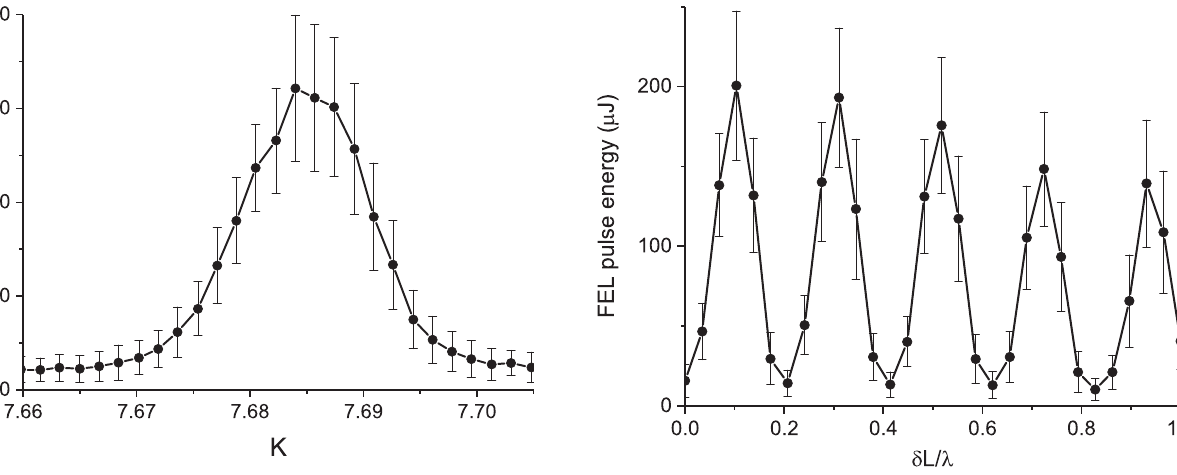
FIG. 6. Synchronous scan of phase shifters after first four undulator segments. The FEL pulse energy is measured after the third part of the undulator tuned to 4.5 keV. Mean pulse energy and its standard deviation are plotted versus a delay measured in units of the fundamental wavelength in the first part (tuned to 900 eV). The FEL operates as a harmonic lasing cascade (five segments at 900 eV, six segments at 1.5 keV, and six segments at 4.5